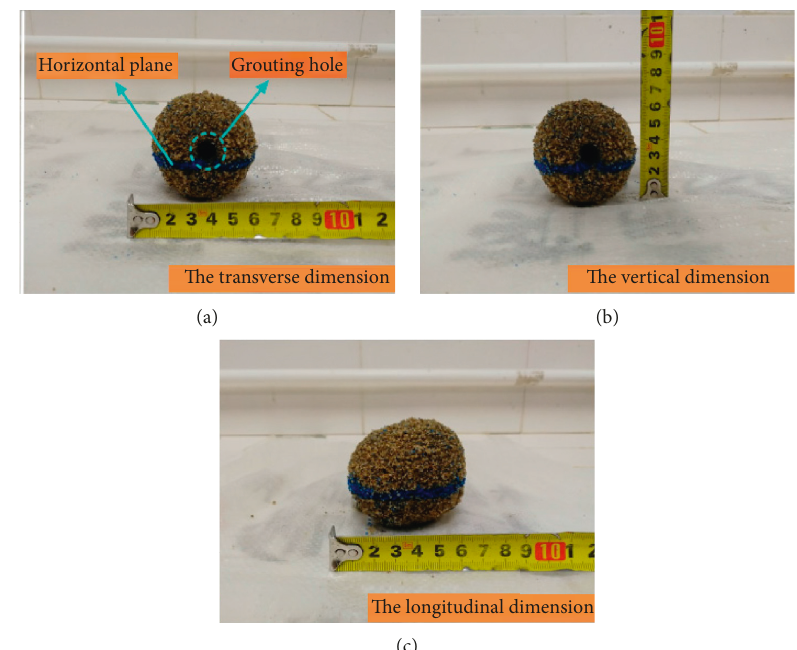
Figure 8: Diagram of the dimension of grout concretion.